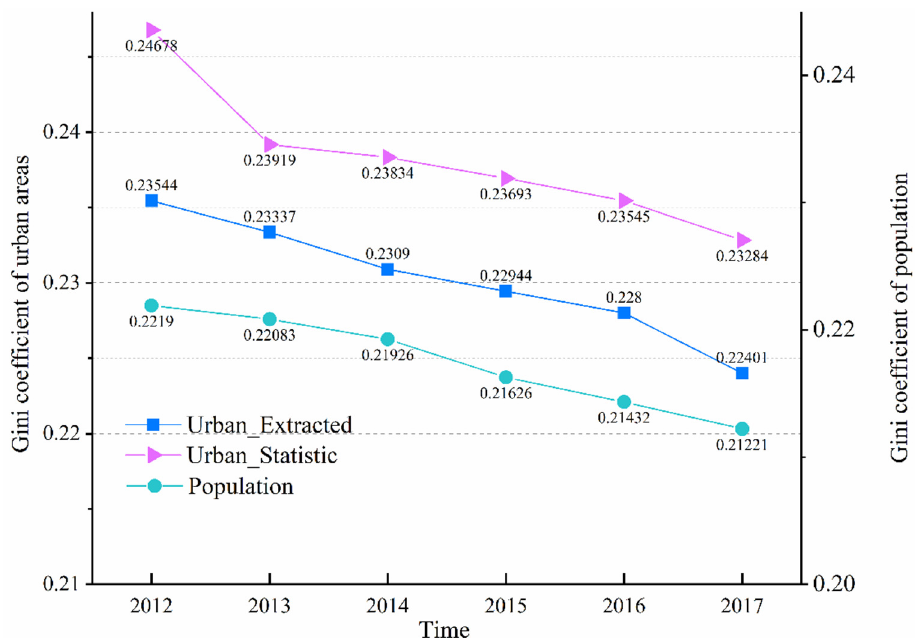
Figure 13. Variations in the Gini coefficient for extracted urban areas, statistic urban areas, and pop- ulation data of the YRD from 2012 to